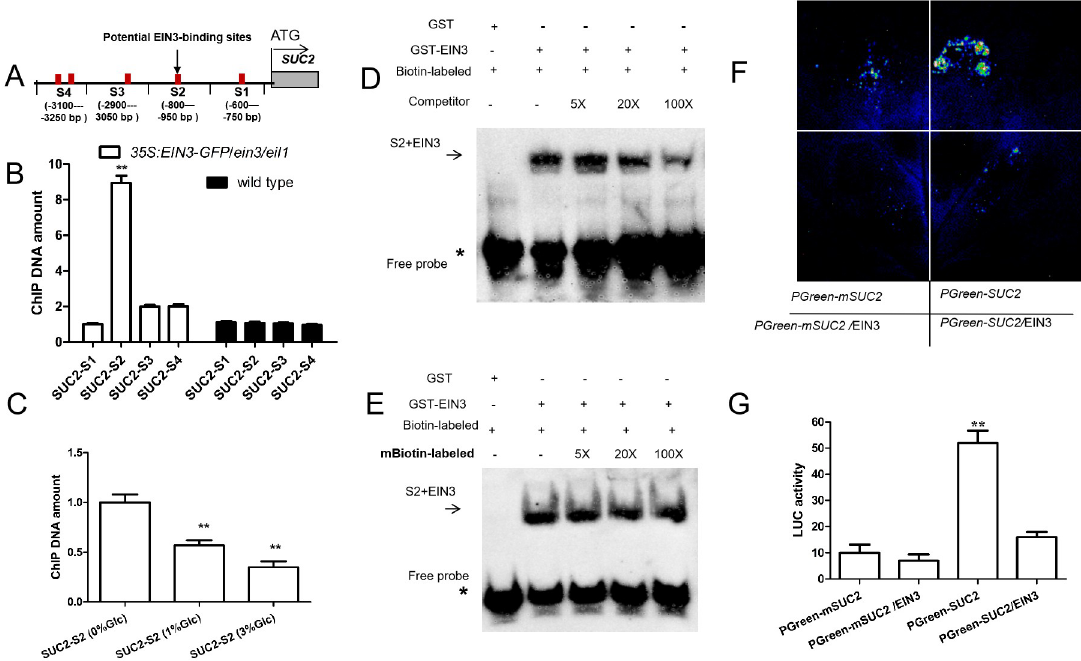
Fig 4. EIN3 directly interacts with promoter of SUC2 to suppress its expression. A , Schematic of the promoter loci of SUC2 and their amplicons for ChIP analysis. B , Bar graph illustrating chromatin immunoprecipitation (ChIP) analysis. Enrichment of particular chromatin regions of SUC2 with anti-GFP antibody in 35S : EIN3-GFP/ein3/eil1 and wild-type seedlings grown in soil for 25 days, as detected by real-time PCR analysis. Quantifications were normalized to the expression of UBQ5 . C , Bar graph illustrating ChIP-PCR in glucose treatment. Ten-day-old 35S : EIN3-GFP/ein3/eil1 seedlings grown in soil. And then these wild-type seedlings were treated by using 0%, 1% and 3% glucose for 30 mins. The ChIP DNA amount at 0% glucose for 30 mins is set as 1.0. Quantification was normalized to the expression of UBQ5 . D , Image illustrating unlabeled promoter of SUC2 were used as competitors to determine the specificity of DNA- binding activity for EIN3. E . Image illustrating a mutant version of the promoter of SUC2 was labeled with biotin and used for EMSA with EIN3 polypeptides. Free probe and EIN3 probe complexes are indicated by an asterisk and arrows, respectively in D and E. F , Image illustrating luminescence units is represented by LUC activity. G , Bar graph illustrating transient expression of the 35S:EIN3 effector construct with the SUC2pro-LUC reporter construct in N . benthamiana leaves. Note PGreen-mSUC2 indicates the conserved sites (TTCAAA) of the S2 region in SUC2 promoter were mutated. The activity of relative LUC represents arbitrary luminescence units, that is, expressing SUC2-LUC is ~10, other expressions was quantified by using Adobe Photoshop CS (AdobeSystems) software, as described previously by [28]. Error bars represent SD (n = 3). Student’s t test ( �� P <